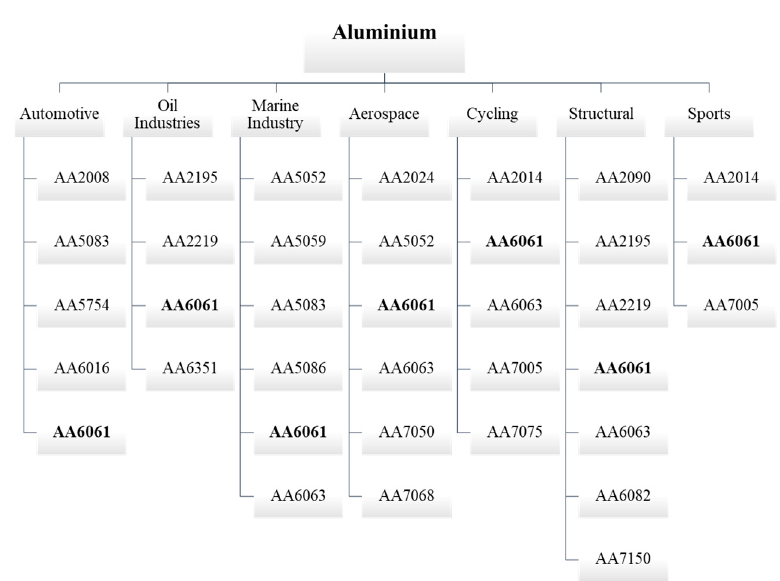
Figure 1. Various grading of AA used in different industries. Table 3. Chemical composition of series 6000 aluminum alloy.